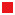
Remaining chlorpyrifos (CHL) (%) and biomass by C1 (a), C4 (b), C7 (c), C8 (d), C9 (3), C10 (f) strains at initial CHL concentration of 0, 10, 20, 50 and 100 mg L-1, evaluated during 120 h. (●) CHL 10 mg L-1; (◼) CHL 20 mg L-1; (x) CHL 50 mg L-1; (◆) CHL 100 mg L-1; (▲) Control without CHL. Continuous line: Remaining CHL (%); Dotted line: biomass (g L-1).